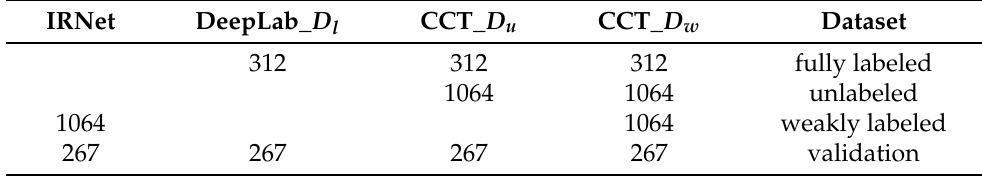
Table 1. Datasets of sliding window images used for training CCT, IRNet and